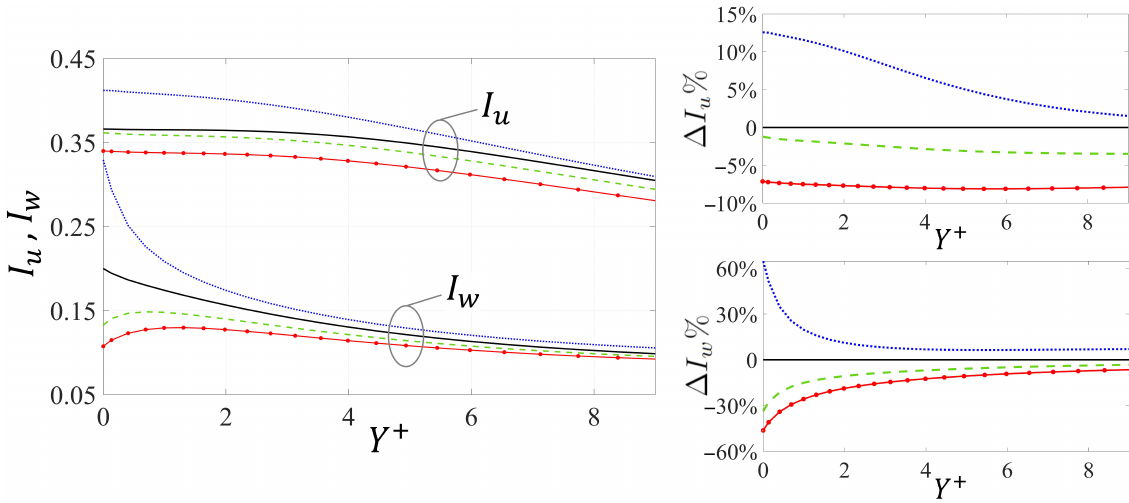
Figure 16. Turbulence intensities ( I u and I w ) near the permeable walls. In the right frames, the percentage deviations of the intensities from the reference smooth channel values are displayed. Symbols are identical to those in Figure